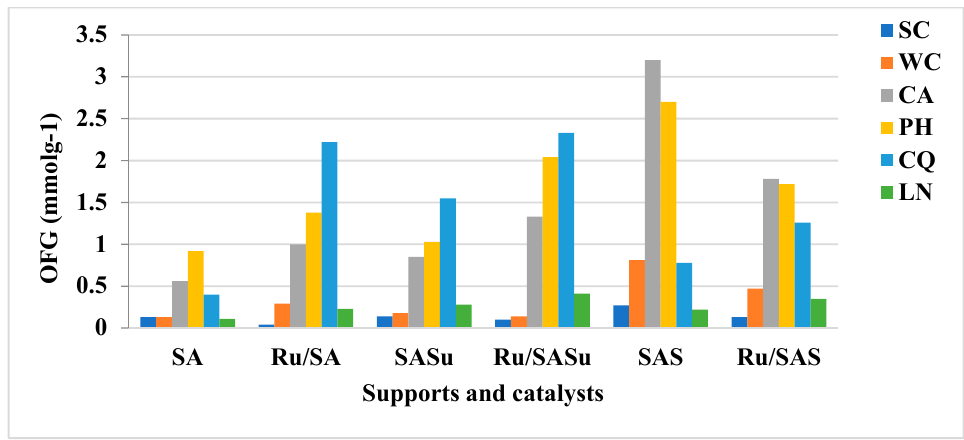
Figure 2. OFG distribution determined by deconvolution of the TPD spectra (SC: Strong acidic carboxyl, WC: Weak acidic carboxyl, CA: Carboxylic anhydride, CQ: Carbonyl or Quinone, PH: Phenol, LN: Lactone).